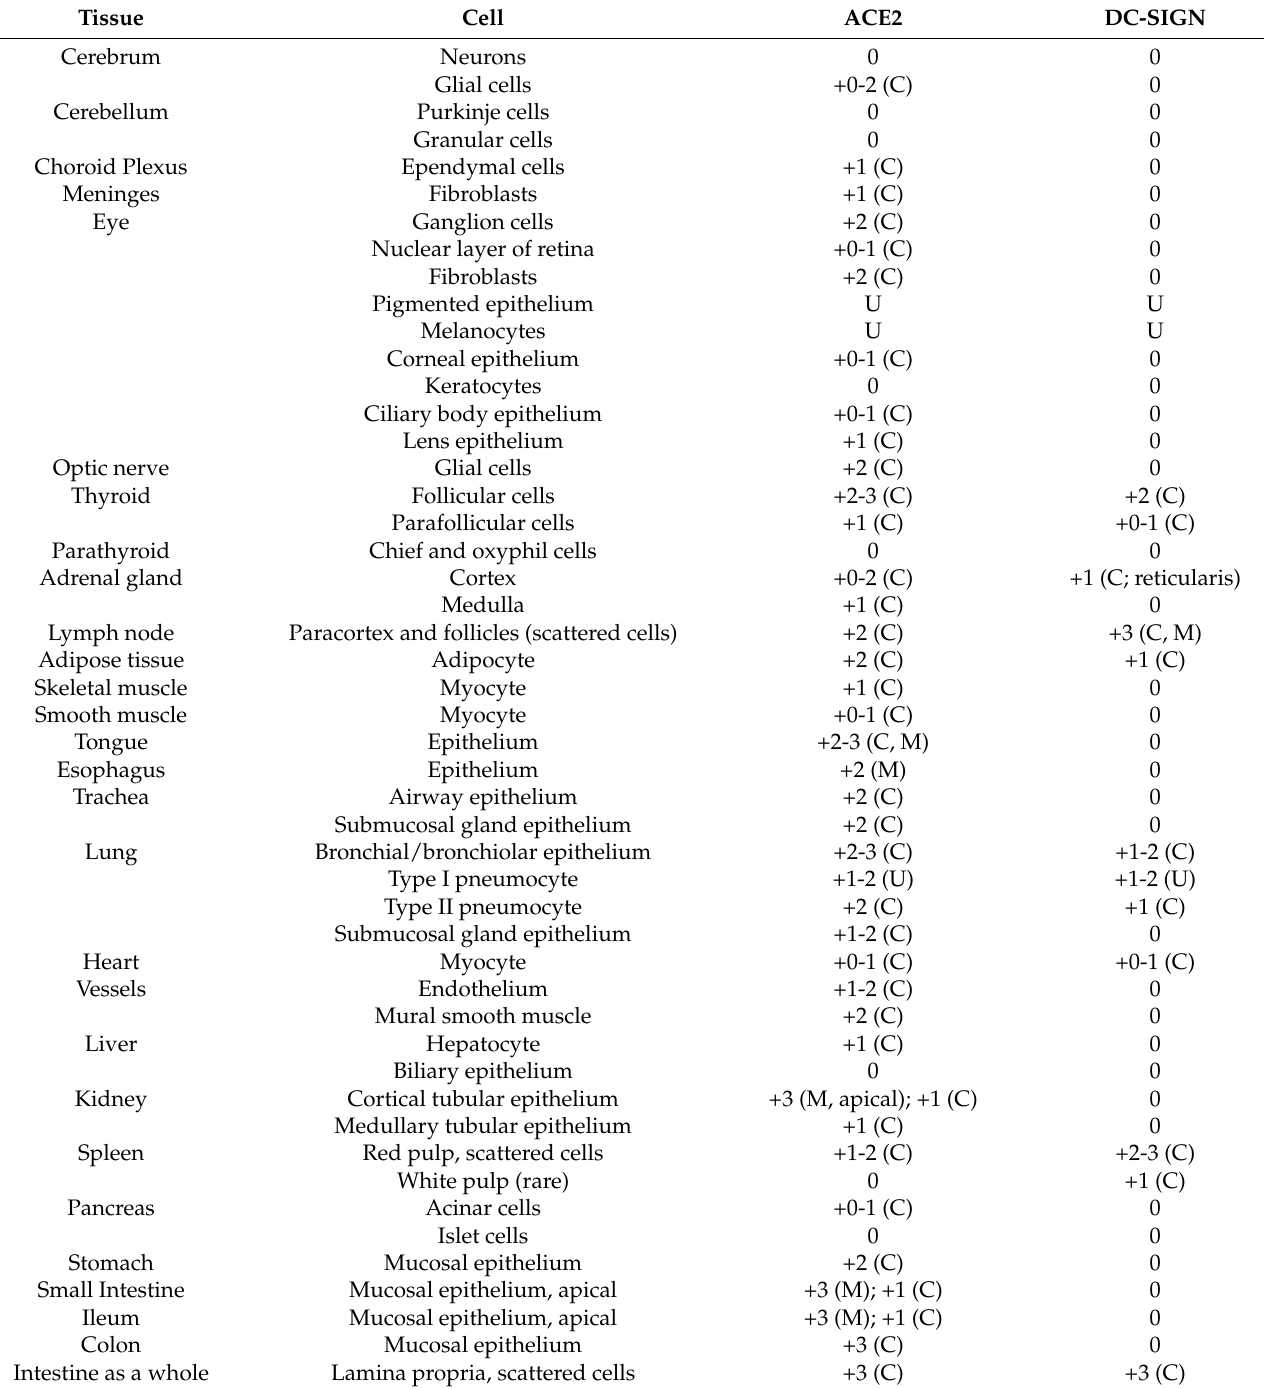
Table 3. List of tissue- and cell-specific immunoreactivity for ACE2 and DC-SIGN in normal feline